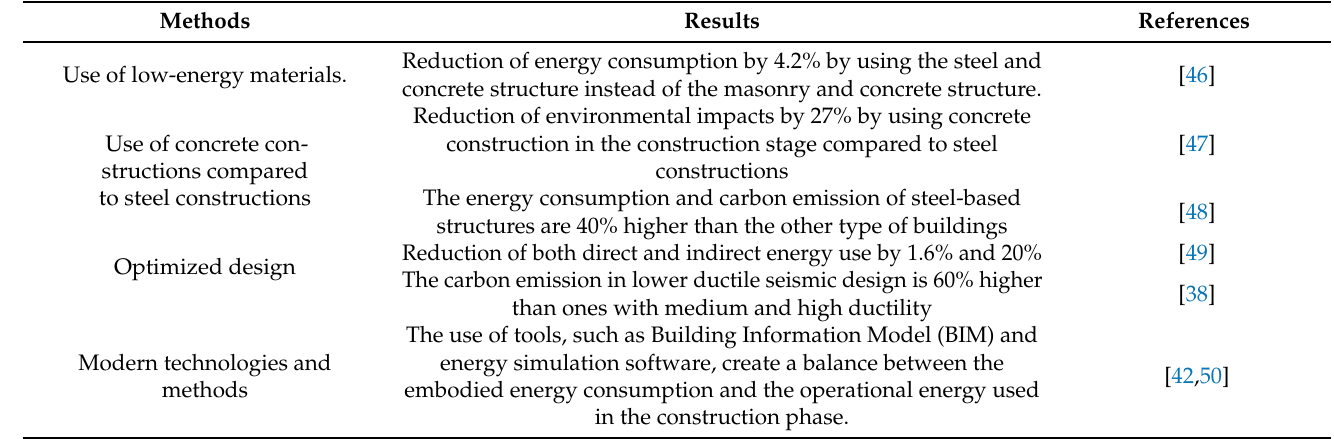
Table 5. The methods presented in previous studies that aim to reduce the negative environmental impacts of construction